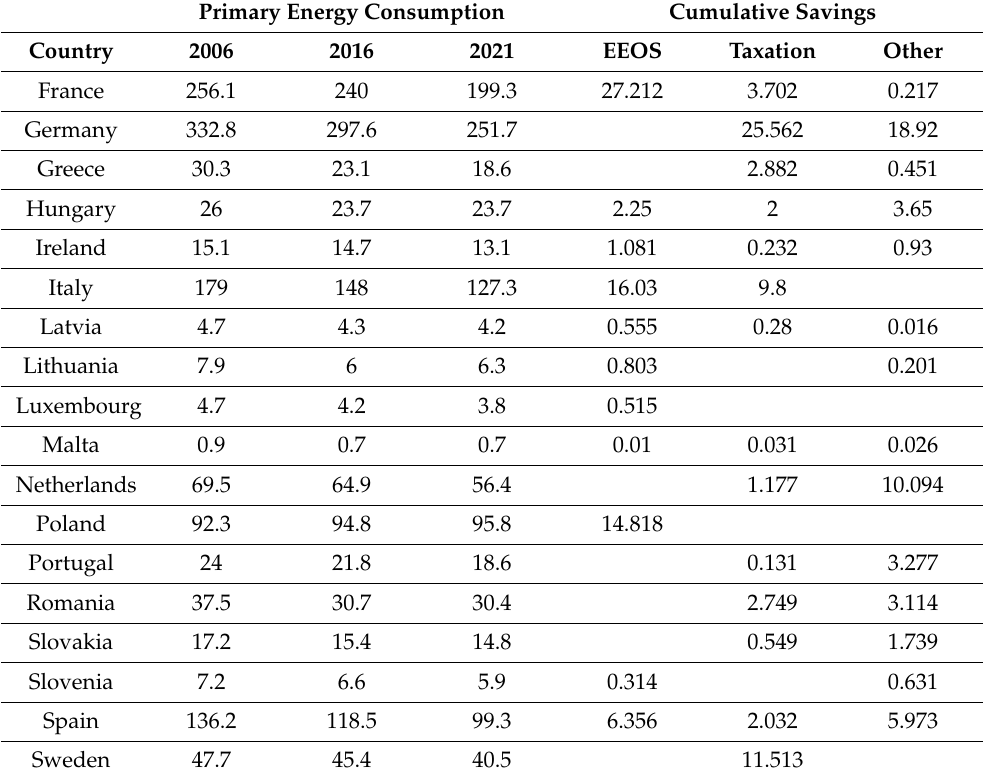
Table 1. Cont. Primary Energy Consumption Cumulative